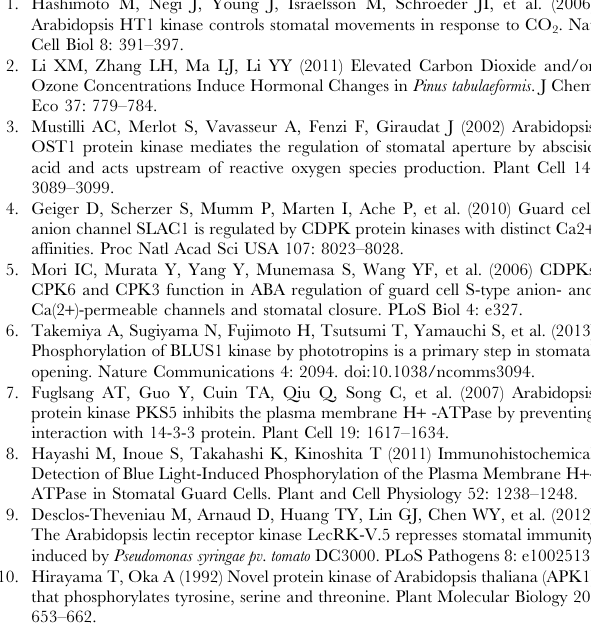
Figure S3 apk1b-1 and apk1b-2 are null mutants. cDNA was synthesised from RNA extracted from seedlings of the T-DNA disruption mutant apk1b-1 and apkb1-2 and Col-0 control and amplified with gene specific primers, for 35 cycles before electrophoresis. No wild-type APK1b transcript was amplified from either mutant. (TIF) Figure S4 Photosynthesis and intracellular CO 2 in apk1b-1 mutants. IRGA photosynthetic parameters measured by IRGA of leaves. A, C & E: Assimilation rate; B, D & F: intercellular CO 2 levels. A & B: Leaves of plants exposed to saturating light for 30 min, then exposed to darkness, arrow indicates when light was switched off. C & D: Leaves exposed to increasing light intensities ranging from 0 to 2000 m mol photon m 2 2 s 2 1 . E & F: Leaves of plants exposed to red light for 60 min, then exposed to blue and red light, arrow indicates when blue light is switched on. Error bars represent the standard errors. Values were statistically tested using unpaired t-tests and significant differences are indicated (** = p ,